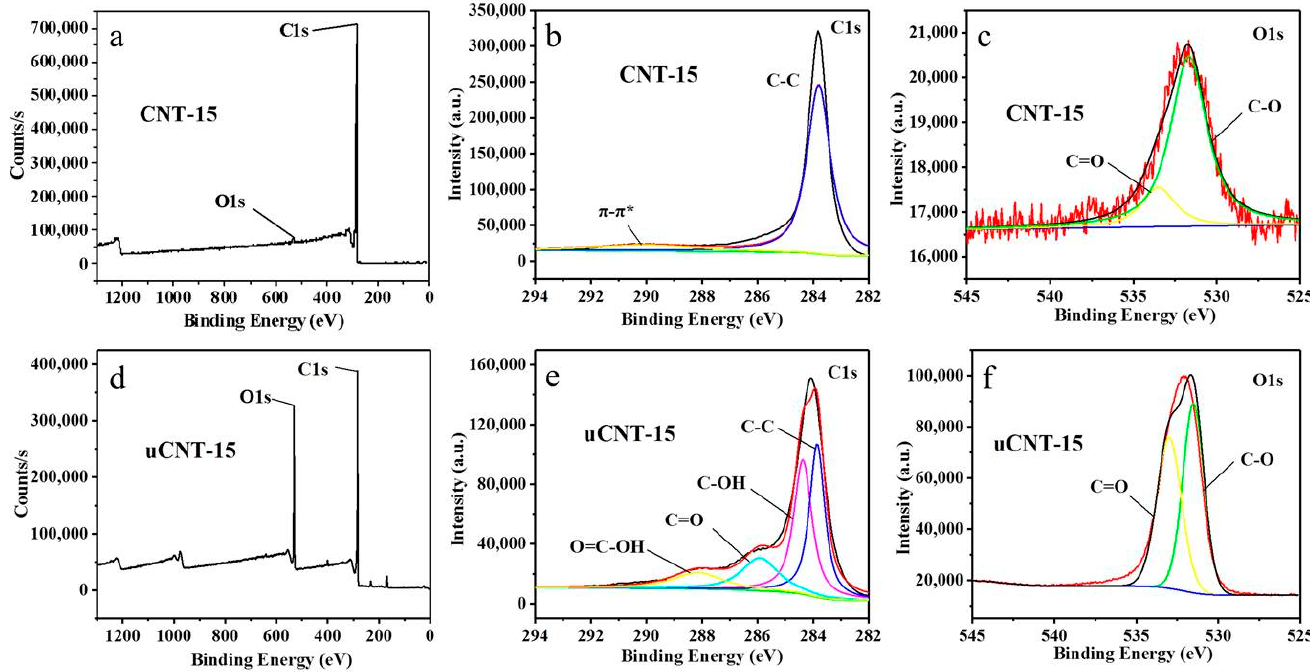
Table 3. Element percentage distributions of CNT-15, uCNT-15, CNT-23, uCNT-23, CNT-45, and uCNT-45.